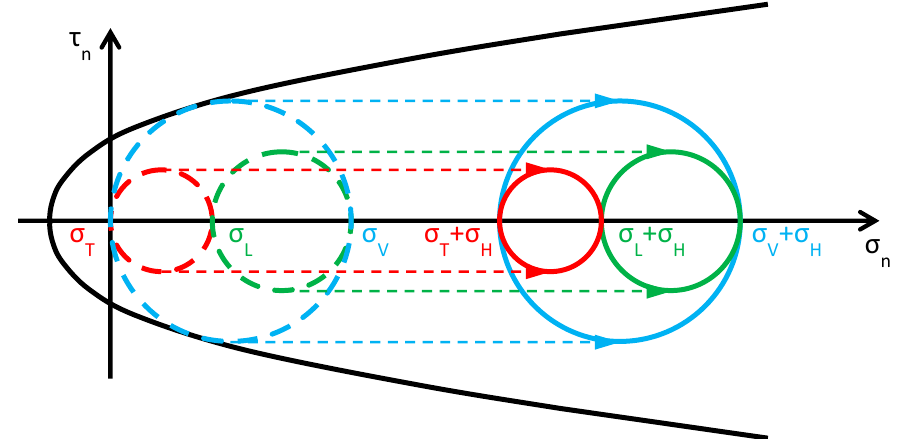
Figure 20. How previous papers assume that the CAM system acts on Mohr’s circles (Mohr’s circles before retrofitting in dashed lines, for comparison).